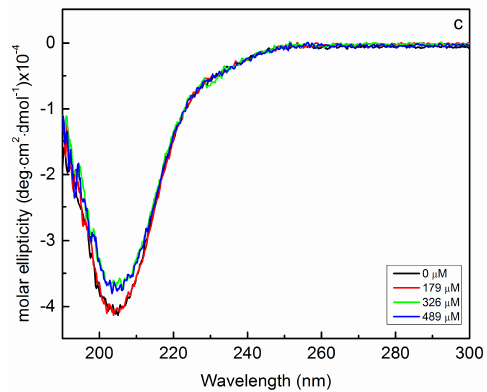
Figure 6. Bac7(1–35) CD changes in phosphate buffer as a function of increasing concentration of polysaccharides extracted from KpTs101 ( a ); KpTs113 ( b ); and KpMn7 ( c ) biofilms. The small changes observed might be due either to limited interaction between the peptide and the EPOLs or to the fact that interaction do exists but does not greatly affect the peptide conformation. Nevertheless, the lowest spectroscopic variation in the CD curves was obtained for the peptide/KpMn7 EPOL system, as in the case of the BMAP-27 study. In fact, the first addition of the polysaccharide (Figure 6c, red curve) did not change the shape of the spectrum, which is identical to that of the peptide alone.